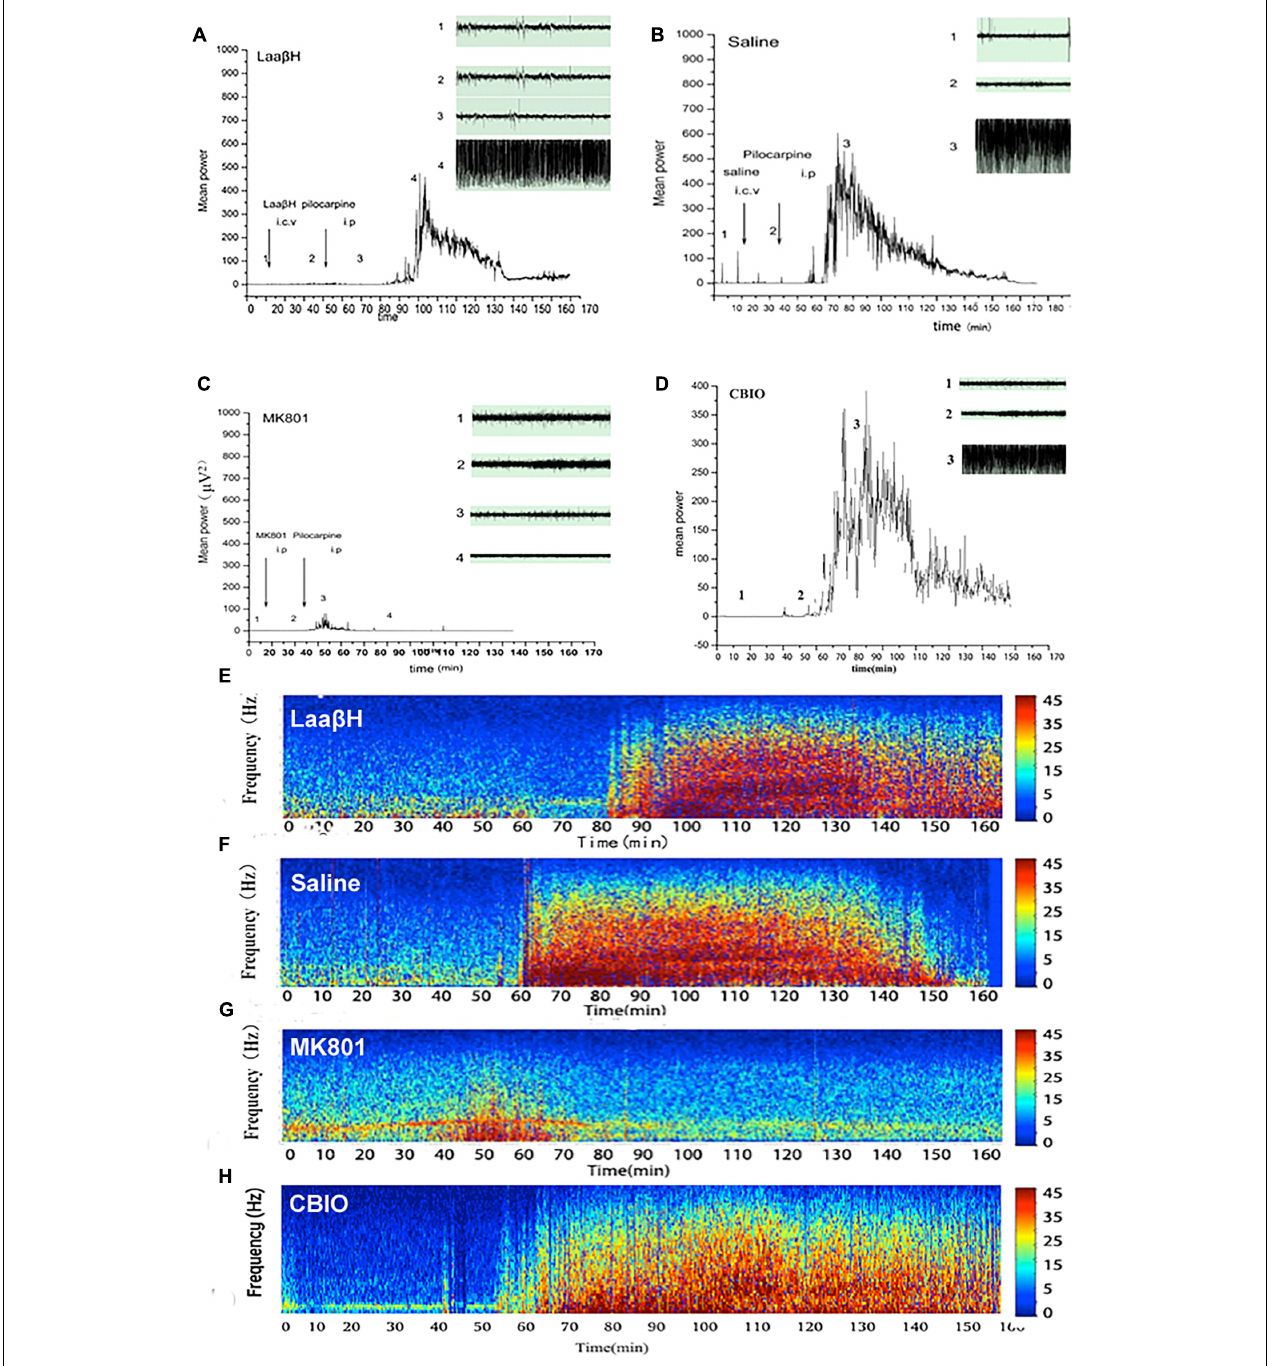
FIGURE 5 | Effects of MK801, Laa β H, and CBIO on the EEG recordings. (A–D) Mean power of EEG recordings in rats treated with Laa β H (A) , saline (B) , MK801 (C) , and CBIO (D) . (E–H) Representative frequency images of EEG recordings in rats treated with Laa β H (E) , saline (F) , MK801 (G) , and CBIO (H) . N = 7–9 rats per group. Compared with the saline control, Laa β H could prolong the onset of seizure occurrence and reduce the mean power of the EEG, while CBIO could shorten the onset of seizure induction and increase the mean power of the EEG.